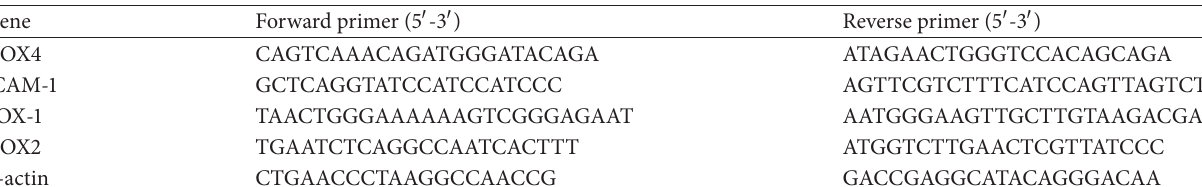
Table 1: Primers for RT-PCR.